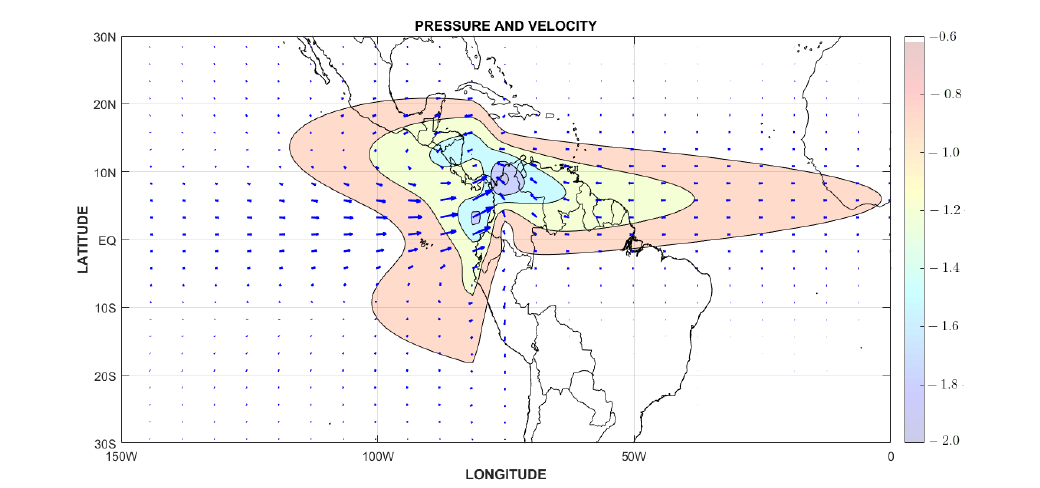
Figure 6. Surface flow (wind arrows) and pressure contours over Northern South America and Meso-America for a diabatic heating source located at 5 ◦ N ( k = 4, a = 5, I = 1 and y 0 = 0.5) in the presence of an ambient easterly wind ( ∆ = −